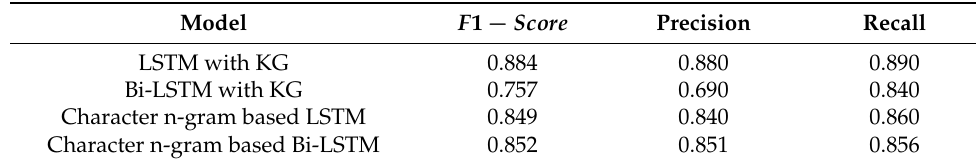
Table 3. Results for